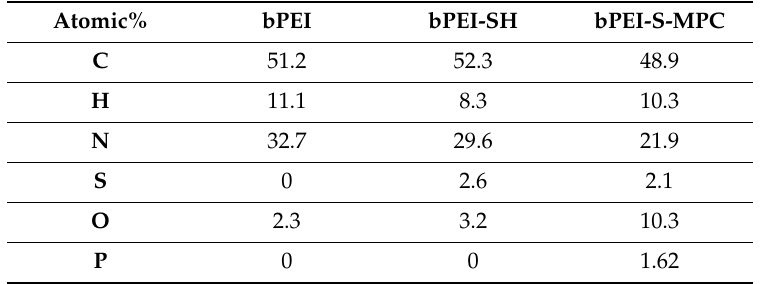
Table 1. Atomic content in the coating complex, obtained by elemental analysis.